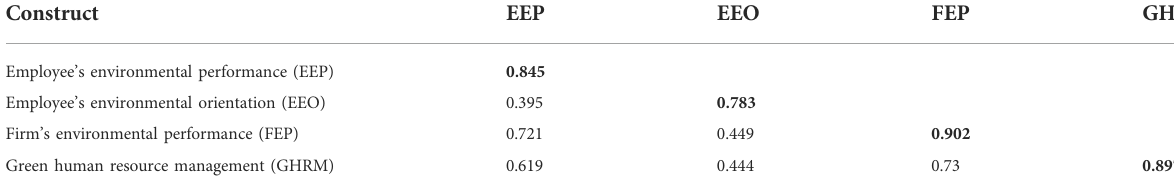
TABLE 2 Discriminant validity using Fornell – Larcker criterion.